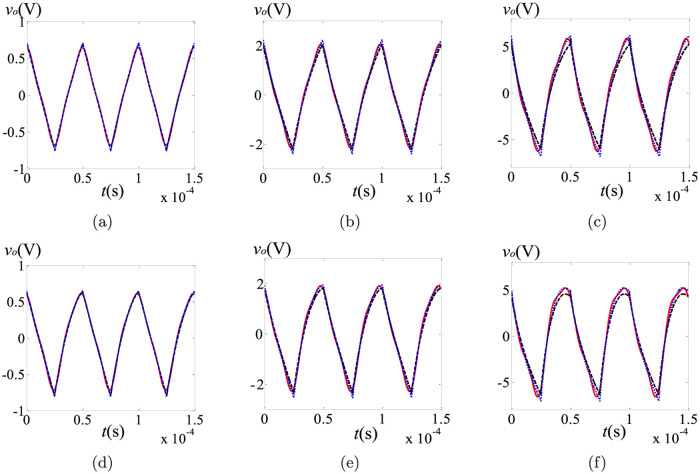
Comparison of the steady state ripples in vo under different fractional orders: (a) (α, β, γ) = (1, 1, 0.95); (b) (α, β, γ) = (1, 0.9, 0.95); (c) (α, β, γ) = (1, 0.8, 0.95); (d) (α, β, γ) = (0.9, 1, 0.95); (e) (α, β, γ) = (0.9, 0.9, 0.95); (f) (α, β, γ) = (0.9, 0.8, 0.95).